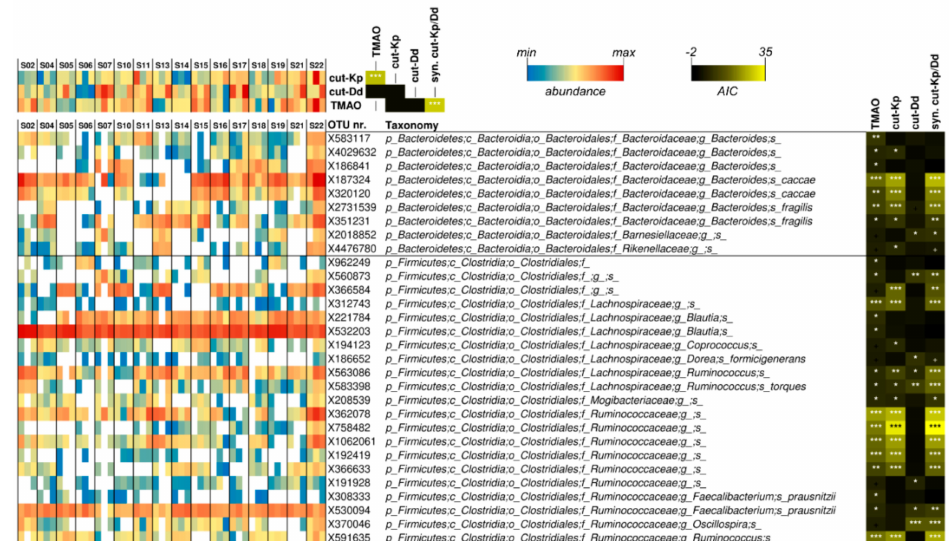
Figure 3. Analysis of the associations among fecal cutC gene abundances, fecal bacterial operational taxonomic units (OTUs), and urinary excreted TMAO carried out through a linear mixed model (LMM). Only OTUs that showed a significant association with cutC or TMAO are reported. The heatmap on the right represents TMAO levels, and cutC gene and OTU relative abundances. White boxes in the blue-yellow-red heatmap indicate that the OTU was not detected in that specific sample. The taxonomic lineage of each taxon is shown: p, phylum; c, class; o, order; f, family; g, genus; s, species. The black-yellow heatmap represents the Akaike’s information criterion (AIC) values of the LMM analysis. Asterisks indicate significant associations: * p < 0.05; ** p < 0.01; *** p < 0.001; + , p < 0.1. syn. cut-Kp / Dd = synergy between cut-Kp and cut-Dd in LMM